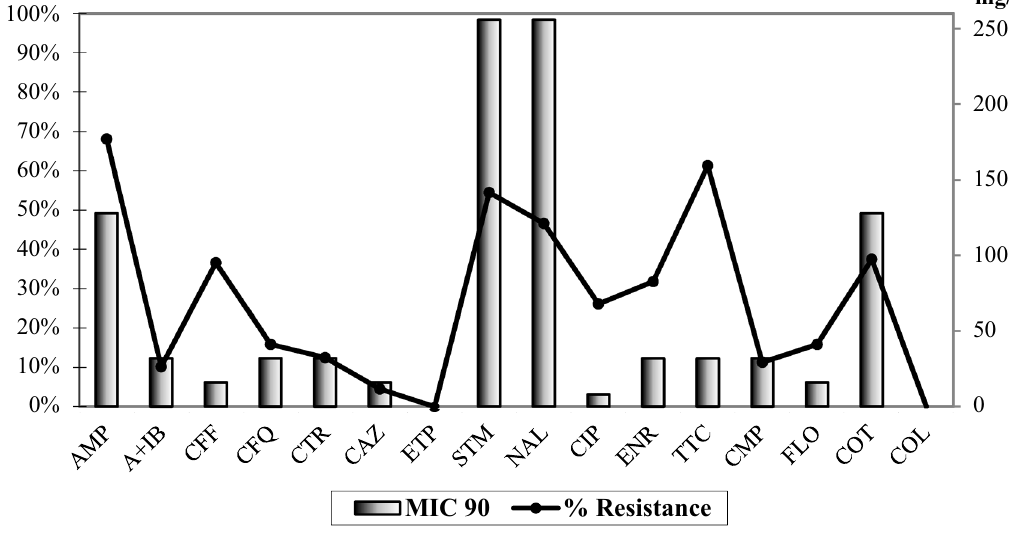
Figure 1. Antibiotic resistance and MIC90 of 88 strains of E. coli isolated from rendering plant.